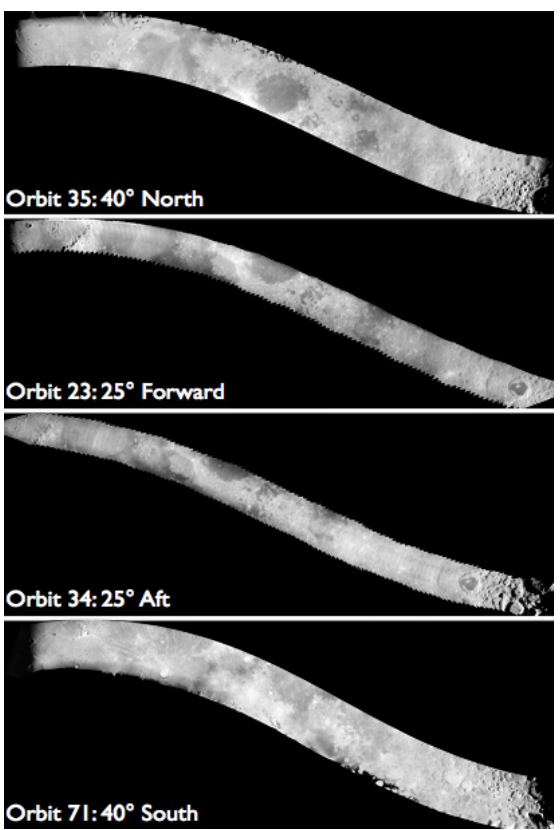
Figure 5: Preliminary controlled DIMs of AS15 oblique orbits. Images are averaged. Projection is simple cylindrical. Original resolution is